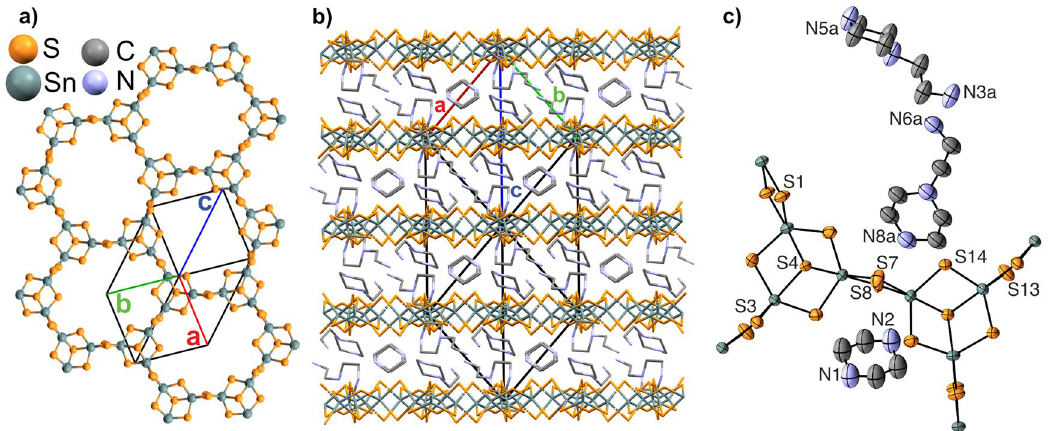
Figure 5. ( a ) Top view of a single [Sn 3 S 72− ] n layer showing non-regular hexagonal pores. ( b ) Side view of AEPz- SnS-1 showing the ordered molecular species (part a ). ( c ) ORTEP representation (50% probability ellipsoids) with selected labels referring to close contacts in Table S6. In ( b , c ) the molecular disorder is not displayed for clarity. See Fig. S12 and S13 for details on the molecular disorder and for full atomic